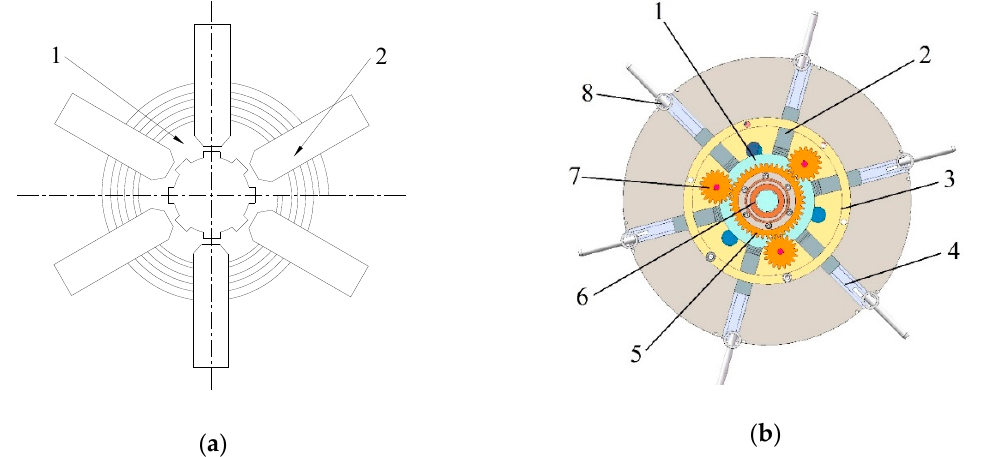
Figure 3. Structure diagram of device for diameter adjustment, 1. Constant speed spiral disc, 2. Claw, 3. Limit disc, 4. Connecting rod, 5. Sun wheel, 6. Spline sleeve, 7. Planet wheel, 8. Threshing tooth rod: ( a ) Constant speed spiral disc and claws; ( b ) device for diameter adjustment.